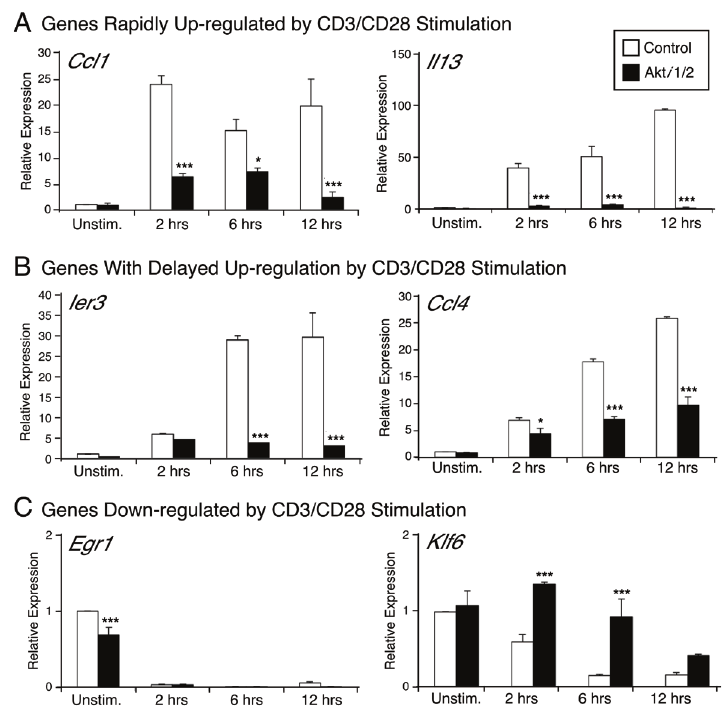
Figure 4. Quantitative real-time PCR (qPCR) confirmation of the stimulation-dependent expression of selected Akt-dependent genes. qPCR was used to validate the gene expression of Ier3 , Il13 , Klf6 , Egr1 , Ccl1 and Ccl4 . The RNA samples were the same as those used for the microarray. Results are presented as relative mRNA expression, compared to the unstimulated control sample, normalized to 18S RNA expression. ***p<0.001, *p<0.05 compared with the control group.